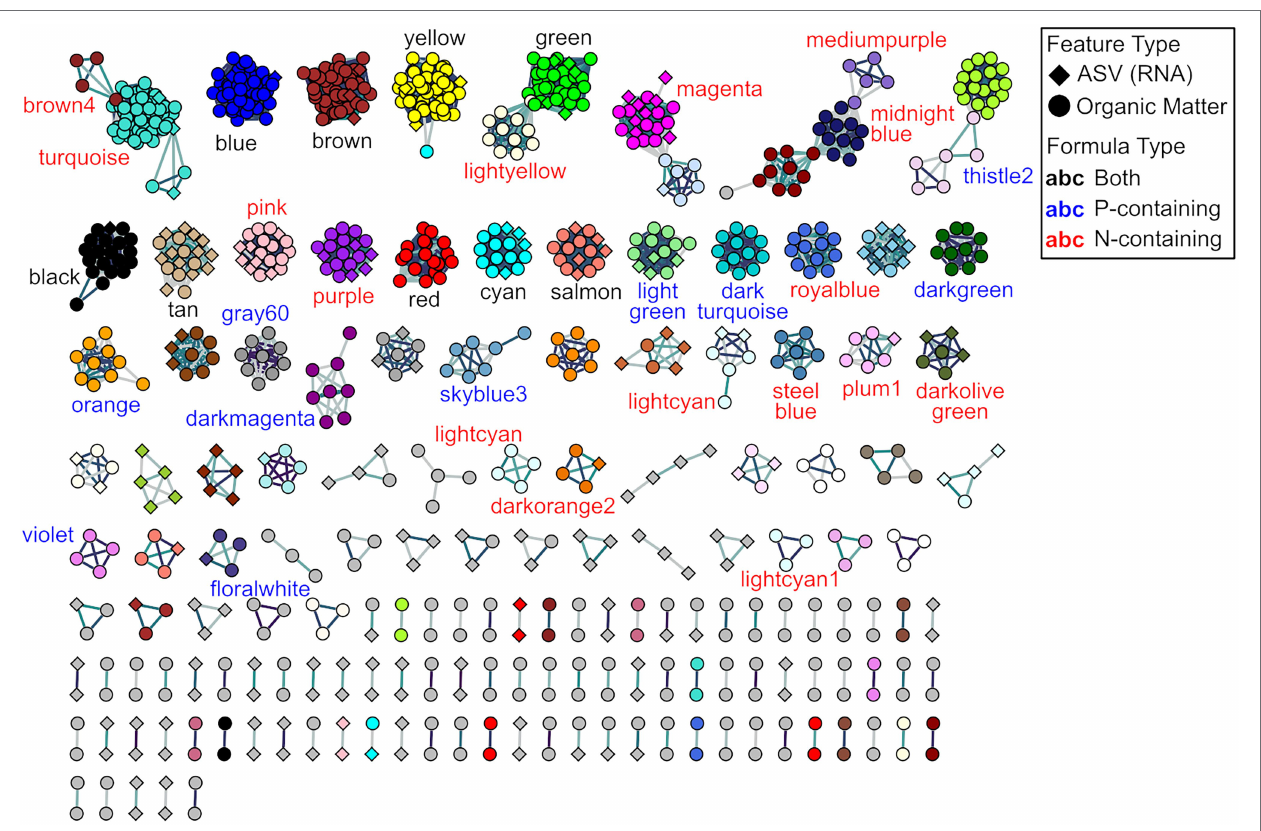
FIGURE 6 | Feature-level β -nearest taxon index ( β NTI feat )-based weighted gene co-expression network analysis (WGCNA). Modules with labels represent those modules which contain N- and/or P-containing molecular formulas. Node colors indicate the different modules identified as part of the WGCNA pipeline, node shapes represent different feature types, and label colors indicate whether the modules contain either N- and/or P-containing molecular